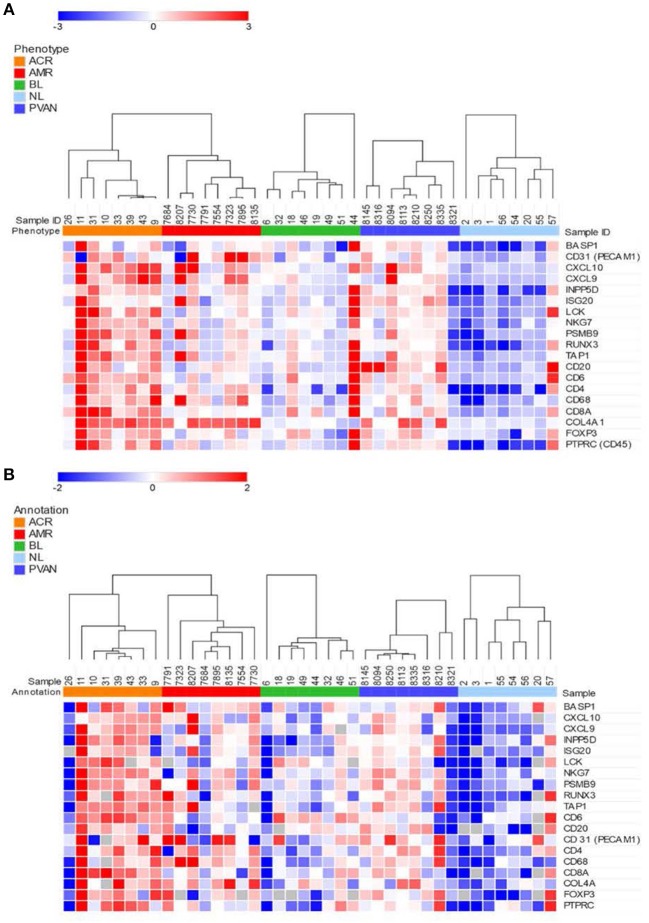
Quantitative methods of gene expression of CRM genes and immune-related genes differentiate kidney transplant biopsies with different transplant injuries. Expression of the genes across 40 unique samples that included 8 NL, 8 TCMR, 8 ABMR, 8 BL, and 8 PVAN. (A) As quantified by NanoString's gene expression platform. (B) As quantified by QPCR (Fluidigm).